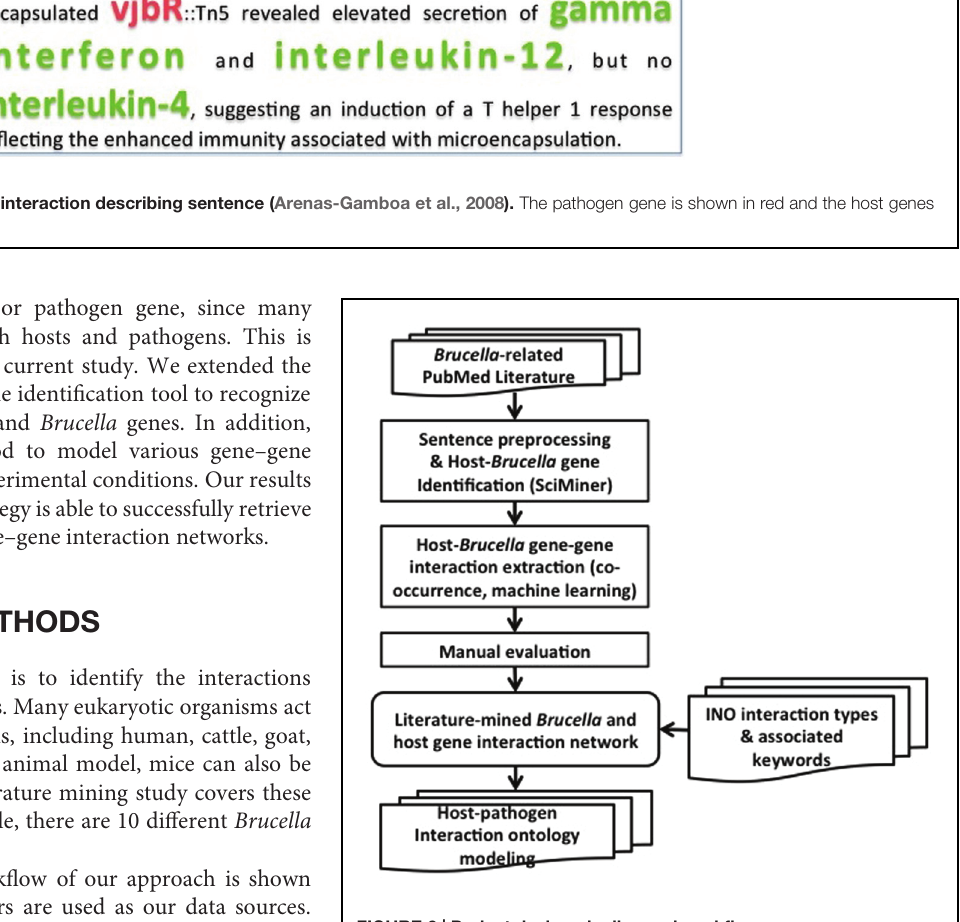
FIGURE 2 | Project design pipeline and